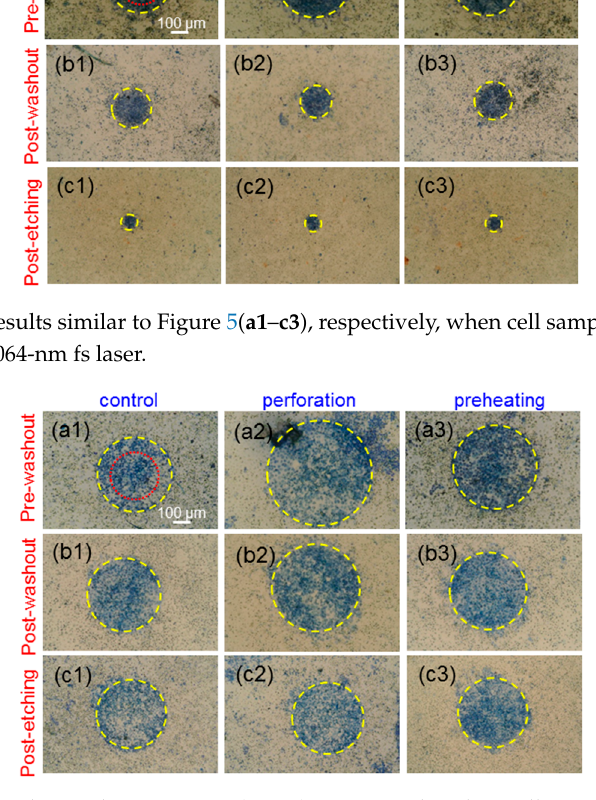
Figure 7. ( a1 – c3 ): Results similar to Figure 5( a1 – c3 ), respectively, when cell samples were illuminated Figure 7. ( a1 )–( c3 ): Results similar to Figures 5( a1 )–4( c3 ), respectively, when cell samples were